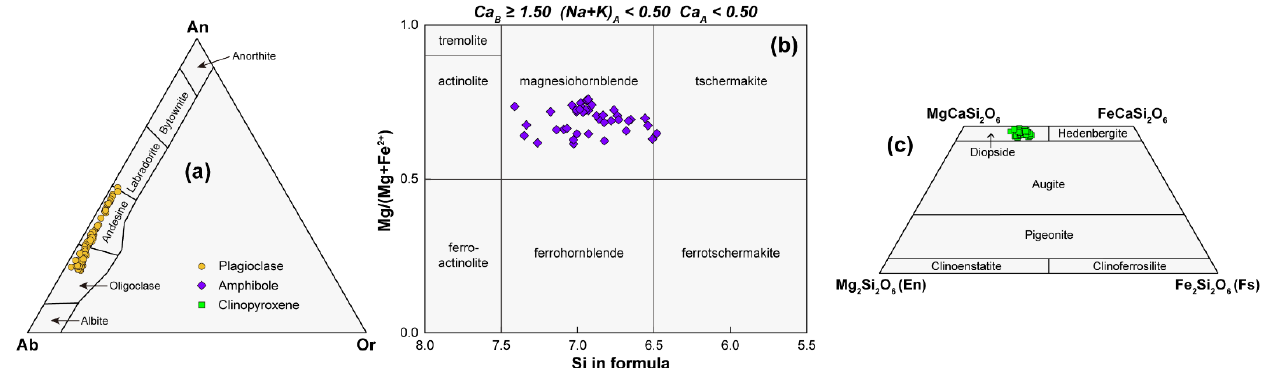
Figure 7. Classification of plagioclase ( a ), amphibole ( b ) and clinopyroxene ( c ). All the analyzed minerals are from the granite samples in this study: plagioclase in 11ZK52-1095 and 11ZK55-993; amphibole in 7ZK50-1184, 7ZK50-1209, 11ZK52-1095, 11ZK52-1174, and 11ZK54-964; clinopyroxene in 7ZK50-1184 and 7ZK52-1225.